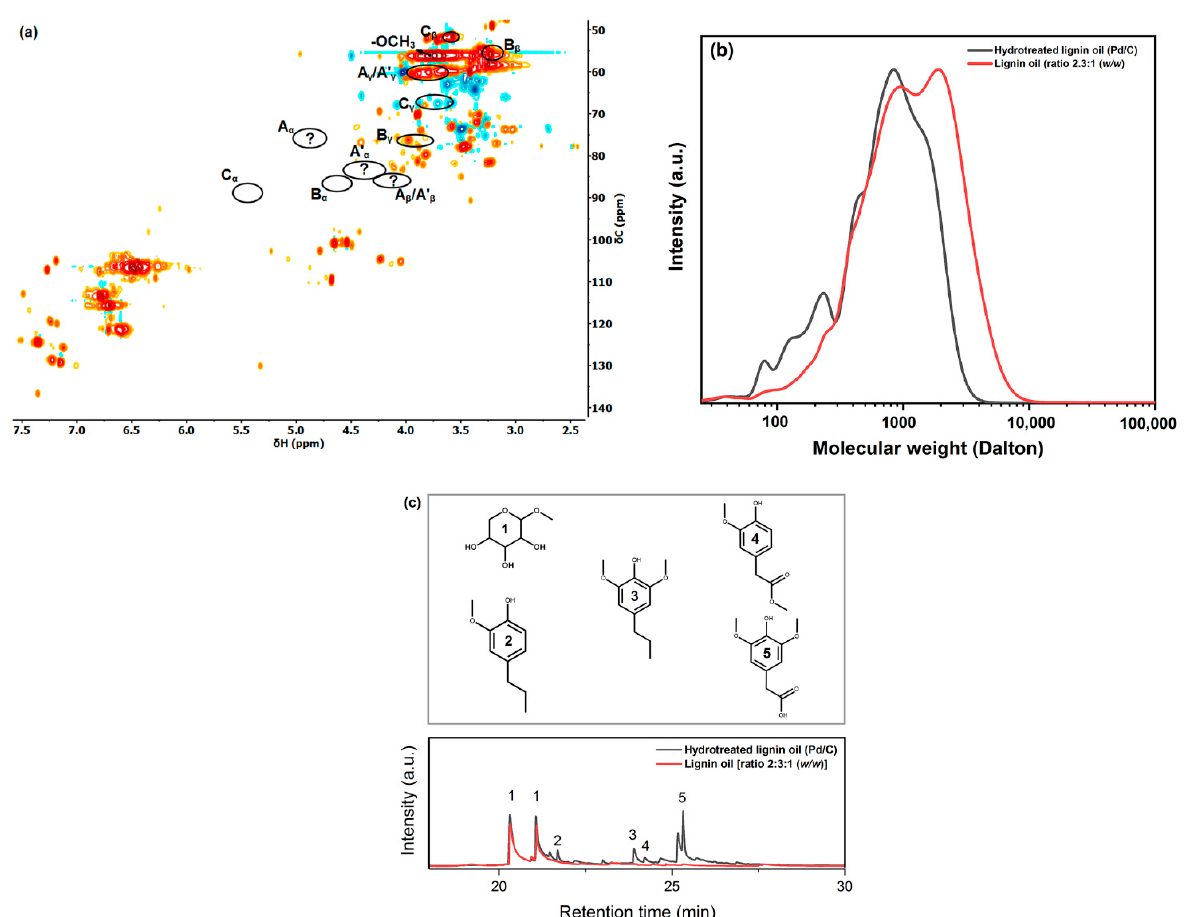
Figure 5. ( a ) HSQC NMR analysis of lignin oil obtained from catalytic hydrogenolysis of lignin oil from entry 13; ( b ) GPC analysis of lignin oils from entry 13 obtained from the first fractionation step (red curve) and the second hydrogenolysis step (black curve); ( c ) gas chromatograms and peak identification of the lignin oil fractions obtained after the first fractionation step (red line) and the second catalytic hydrogenolysis step (black